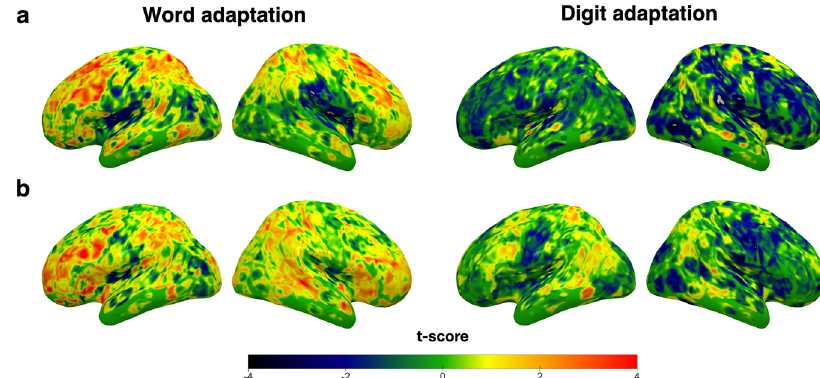
Fig. 7 Unthresholded maps of t values showing the relations between neural adaptation, home literacy practices, and child vocabulary across the whole brain ( n = 44). a Lateral views of the left and right hemispheres showing regions in which neural adaptation to words (left) and digits (right) increased with the overall frequency of home literacy practices. b Lateral views of the left and right hemispheres showing regions in which word adaptation (left) and digit adaptation (right) increased with child